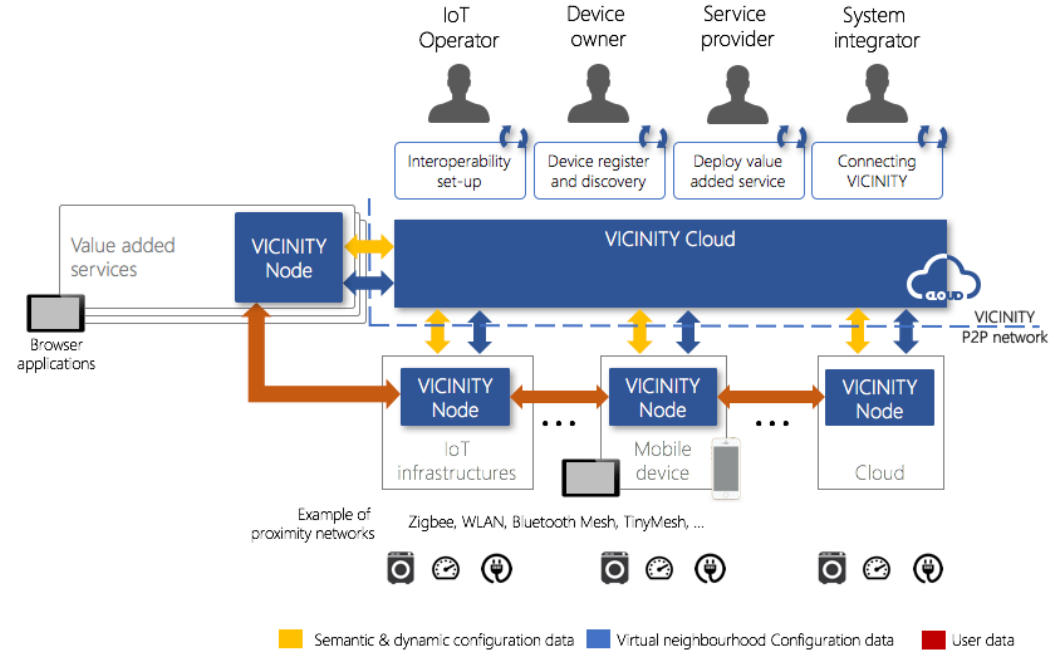
Figure 1. High-level VICINITY architecture Figure 1 High-level logical VICINITY architecture